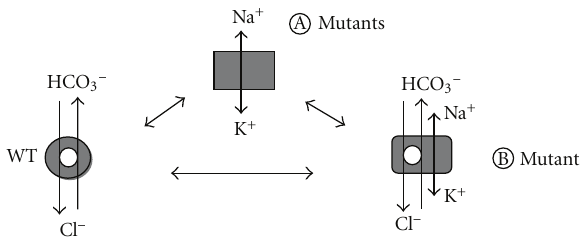
Figure 3: Putative transport states of AE1. Whereas the wt AE1 does only exchange Cl − and HCO 3 − , a A mutated state only conducts monovalent cations and a B mutated state shows both transport activities, anion exchange and cation leak. The A state should be obtained with L687P, D705Y, R730C, S731P, H734R, S762R and G796R mutations. The B state should be obtained with E758K and R760Q